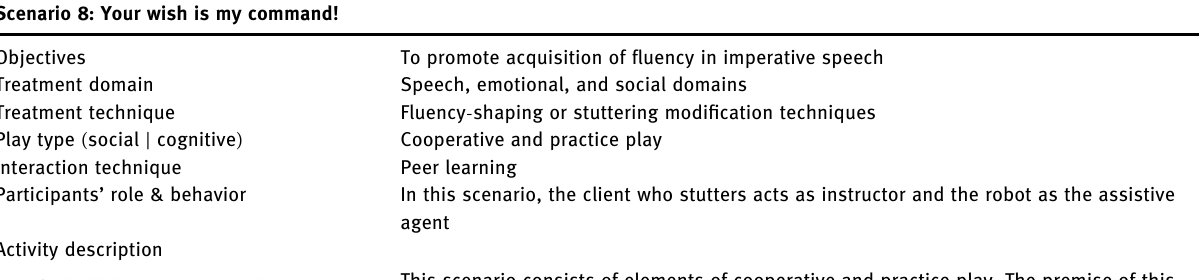
Table 8: Description of scenario 8 Scenario 8: Your wish is my command!